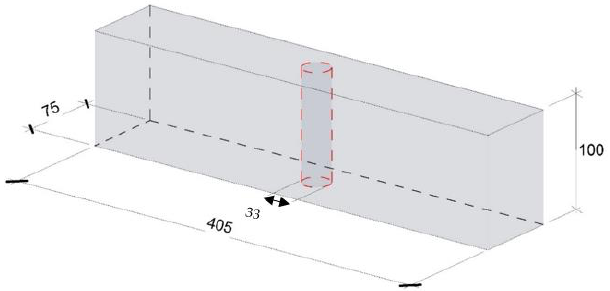
Figure 3. Freeze–thaw beams used for cylinder extraction for X-ray CT scan (mm).